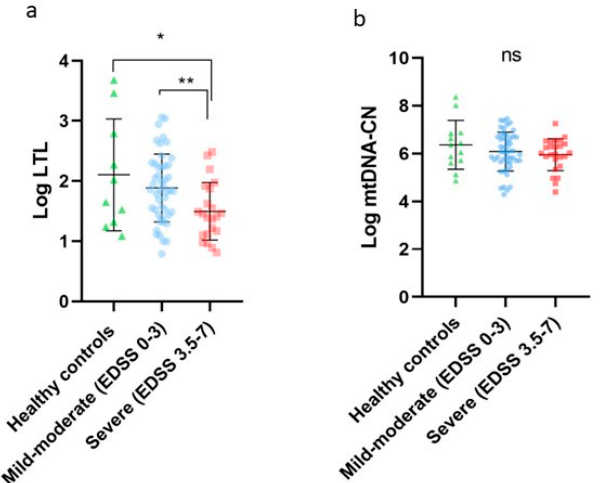
Figure 1. ( a ) Log LTL in RRMS patients; healthy controls (green), mild-moderate disability EDSS 0– 3 (blue), and severe disability EDSS 3.5–7 (red). * p = 0.0094; ** p = 0.0140, and one-way ANOVA p = 0.0130. ( b ) Log mtDNA-CN in RRMS patients: healthy controls (green), mild-moderate disability (blue), and severe disability (red) p = 0.337. (ns) not